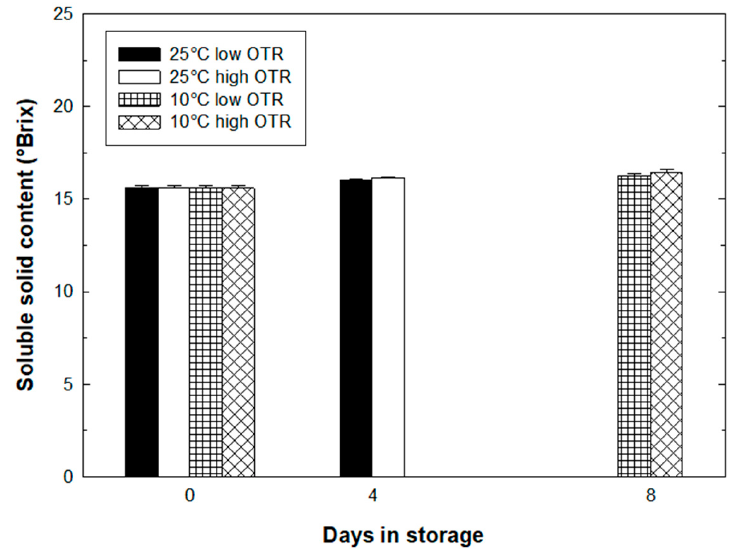
Figure 4. Soluble solid content of ‘Pione’ grapes stored in passive MAP with low and high-OTR films at 25 ◦ C for 4 days and 10 ◦ C for 8 days. Vertical lines represent the standard error of the mean ( n =